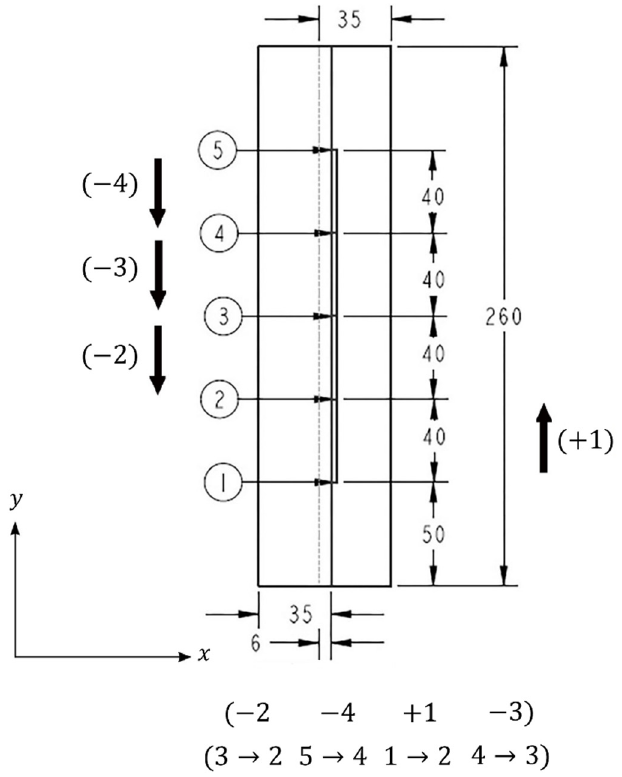
Figure 12. Optimum Welding Sequence.